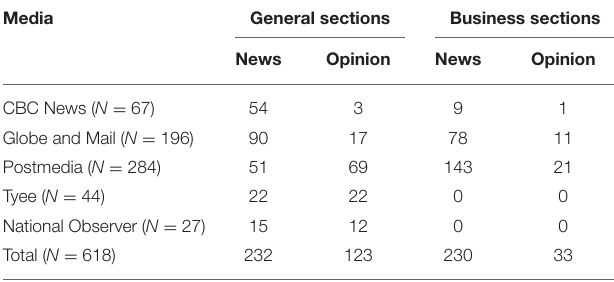
TABLE 4 | PNW news items by content type.